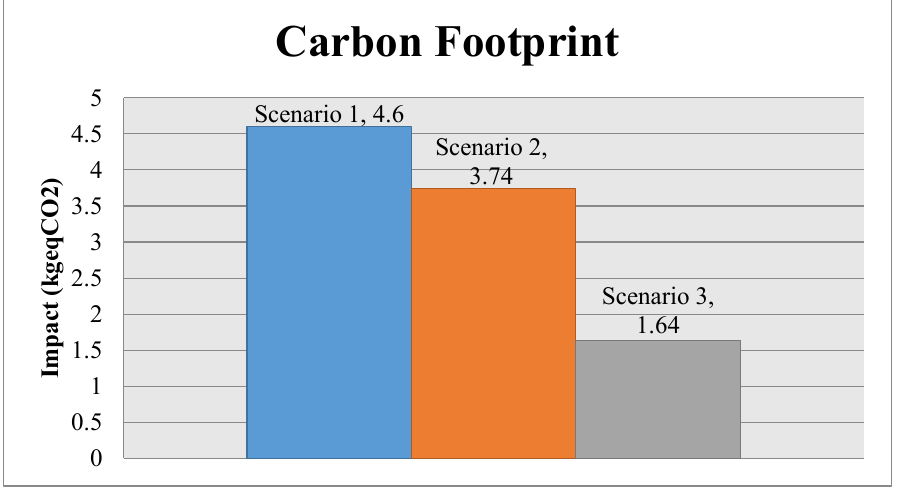
Figure 7. Comparative between scenarios, Carbon footprint.